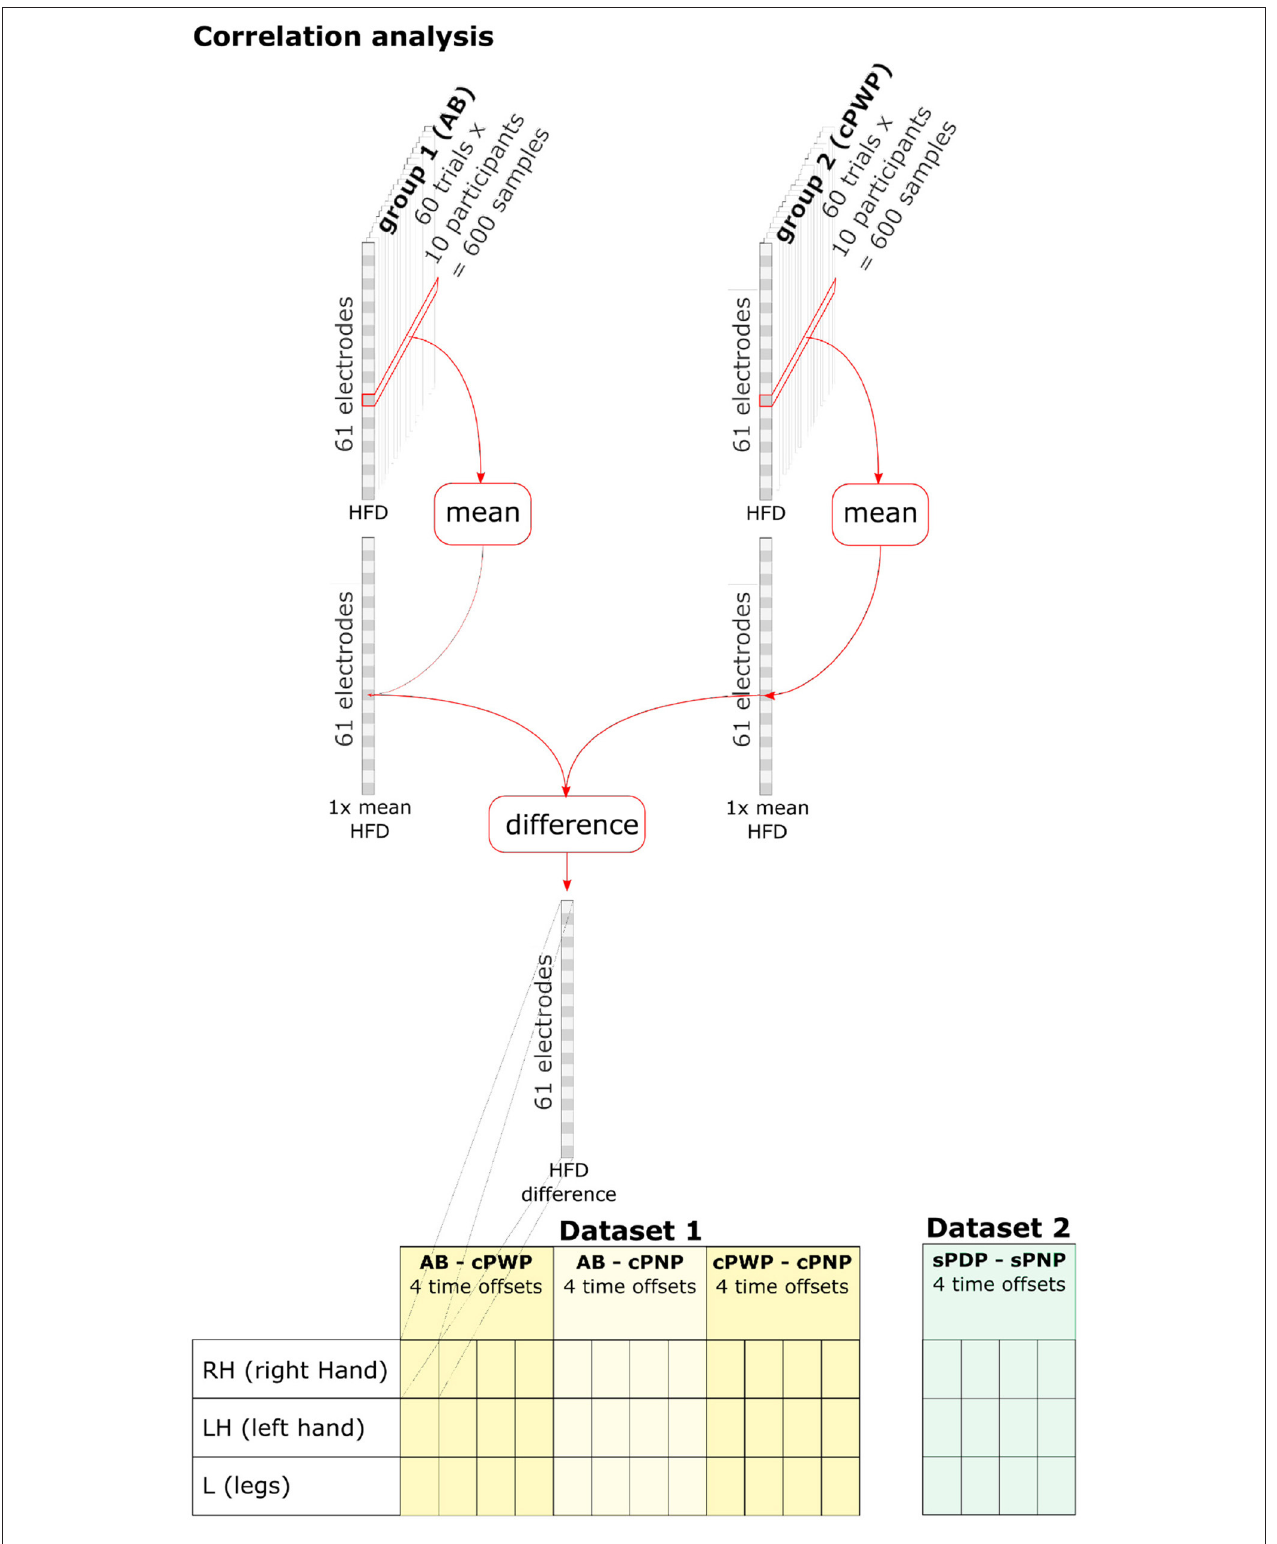
FIGURE 4 | HFD features were aggregated across all trials and participants within each group by estimating their mean value. Group-level differences in HFD features were computed separately for each pair of groups (within each dataset), each time offset, each MI, and each electrode position. See section 2.3 for details.